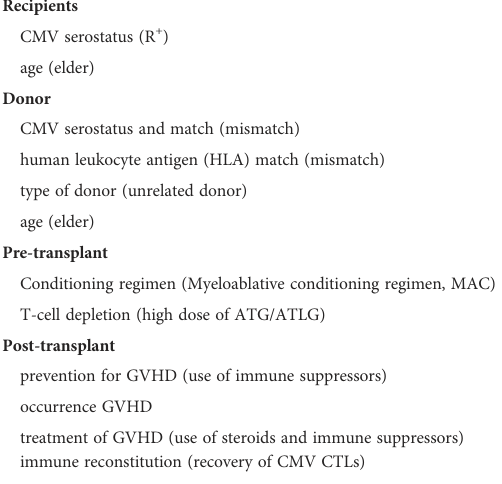
TABLE 1 Risk factors for CMV infection in